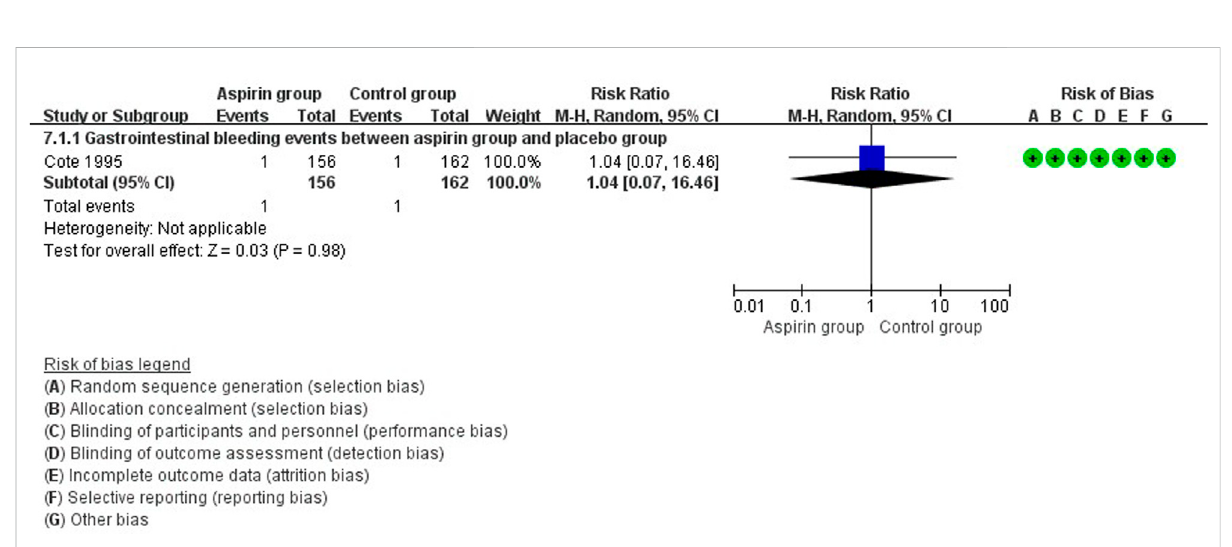
FIGURE 7 Forest plot of gastrointestinal bleeding events between the aspirin group and the control